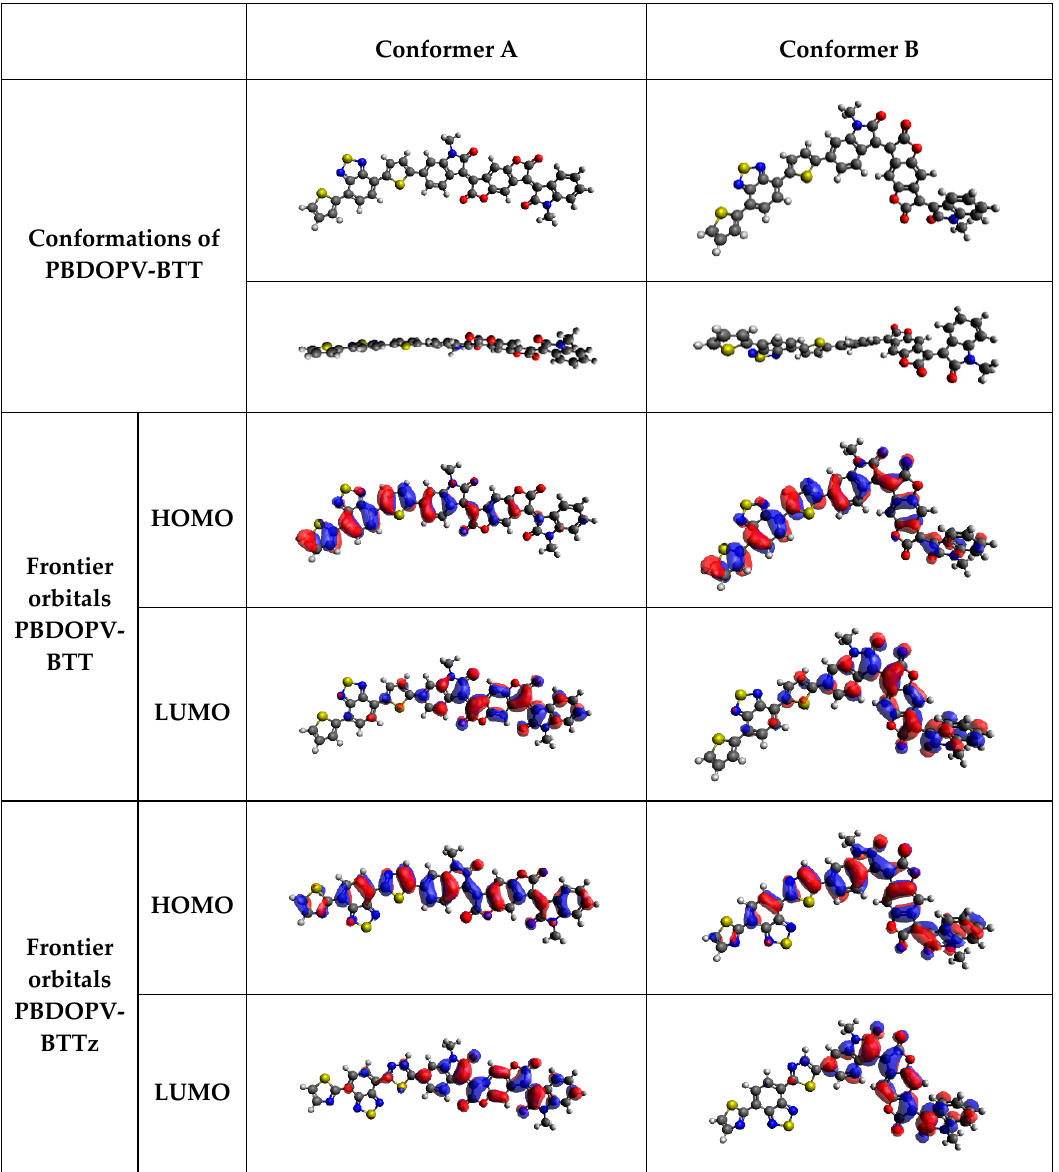
Figure 5. Exemplar top and side views of calculated conformations of the PBDOPV-BTT dimer (analogous for PBDOPV-BTTz). Calculated HOMO and LUMO energy surfaces of the dimer of PBDOPV-BTT and PBDOPV-BTTz (B3LYP/6-31G(d), long and branched alkyl chains are substituted by the methyl group).